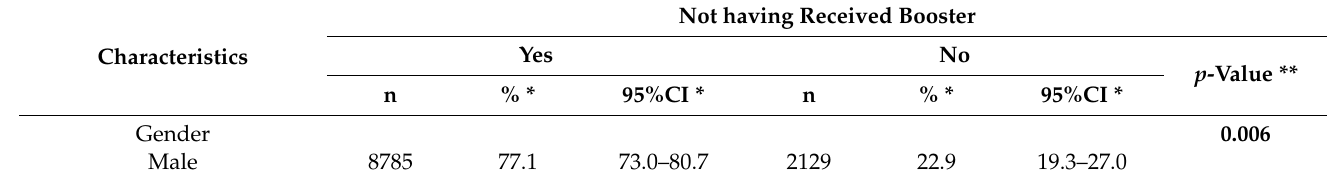
Table 2. Prevalence of not having received the booster dose according to the characteristics of the study